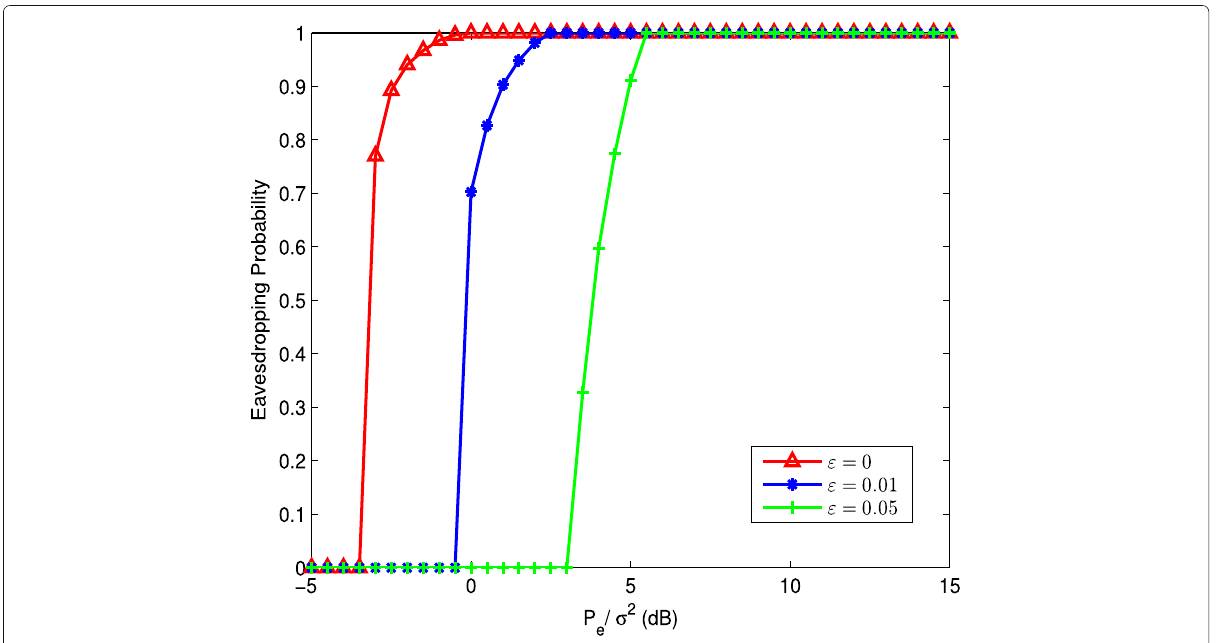
Fig. 6 Eavesdropping probability versus the maximum transmit power at E